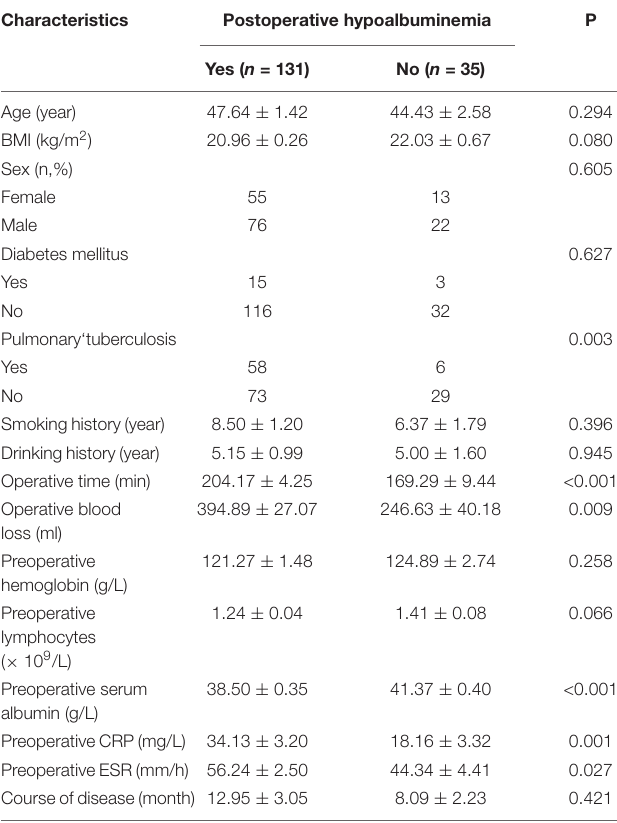
TABLE 1 | Perioperative characteristics of 166 patients with thoracic and lumbar tuberculosis.